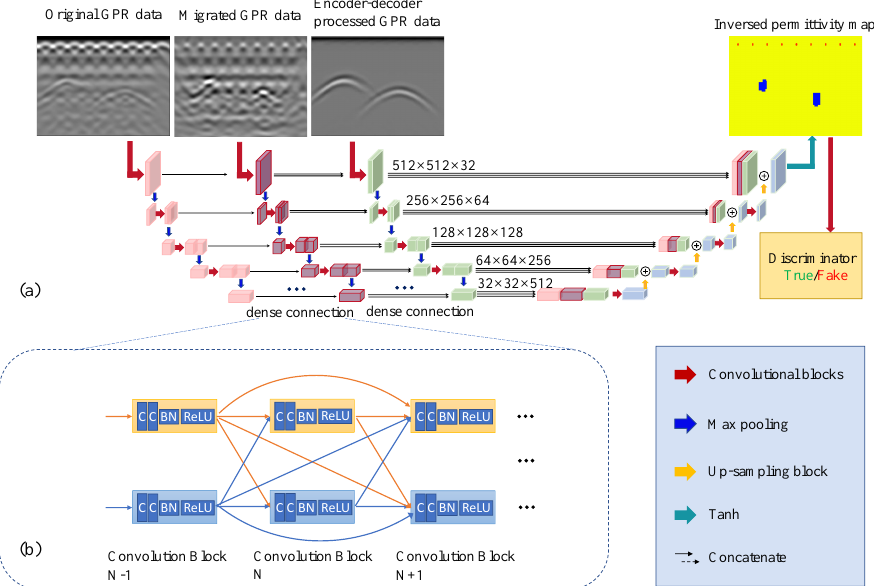
Figure 1. Network configuration. ( a ) Overall structure of the network; ( b ) detailed information of the dense connections between the adjacent encoder